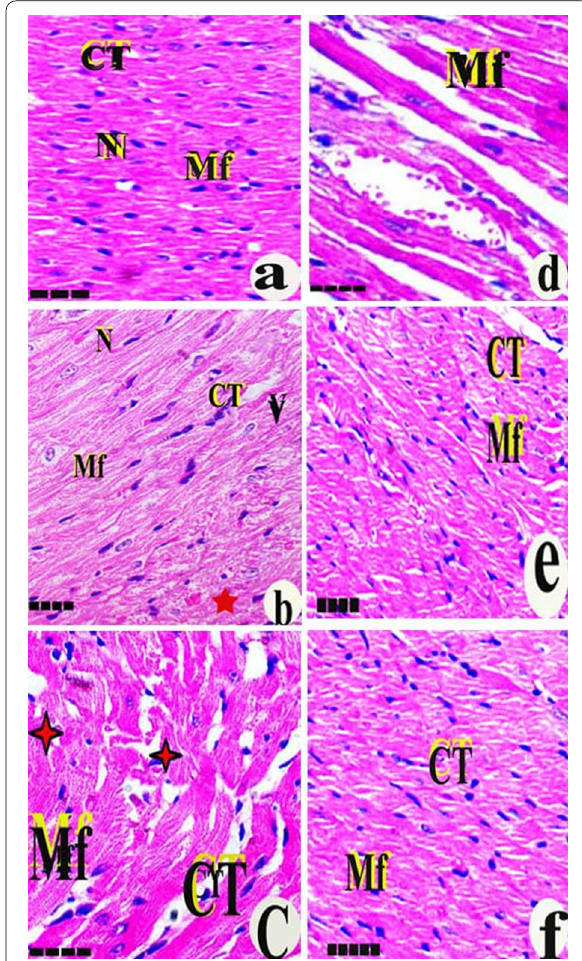
Fig. 6 Photomicrograph of hematoxylin and eosin stained longitudinal cardiac tissue section from a control group showing normal architecture of myocardial fibers (Mf) and normal striations with centrally located oval nuclei (N), acidophilic cytoplasm and connective tissue Scale bar 50 µm. b DMBA treated‑group showing = cardiac muscle fibers (Mf) with nucleus (N), injury characterized by vacuolation (V), necrotic cardiac myocytes (star) and destroyed striations of muscle fibers with irregular distribution of connective tissue (CT), Scale bar 20 µm. c DMBA Art treated‑group = + showing longitudinal cardiac tissue displaying poor